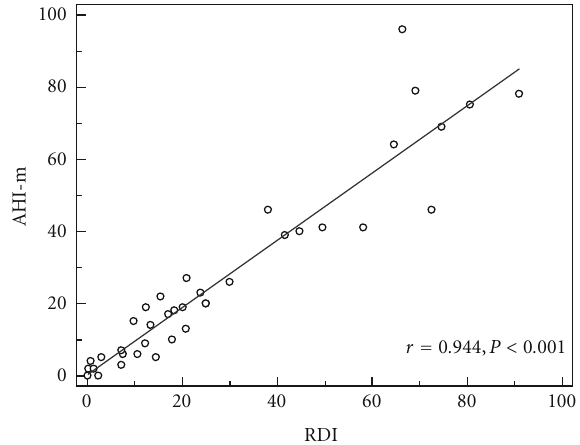
Figure 1: Scatter diagram and regression line between the manual AHI from Apnealink (AHI-m) and the respiratory disturbance index of the polysomnography (RDI).